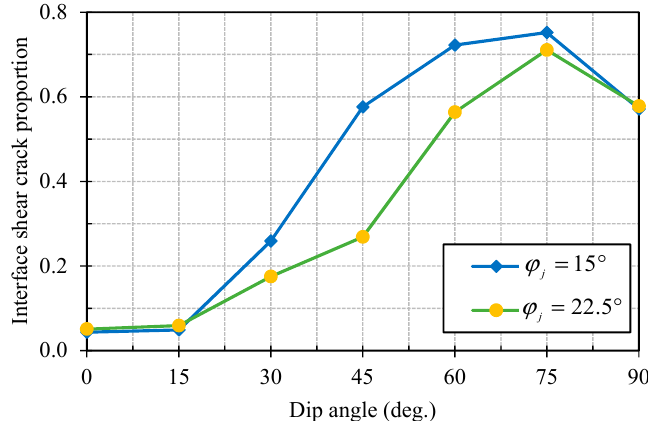
Figure 24. Interface shear crack proportion variation with different bonded joint friction angle.